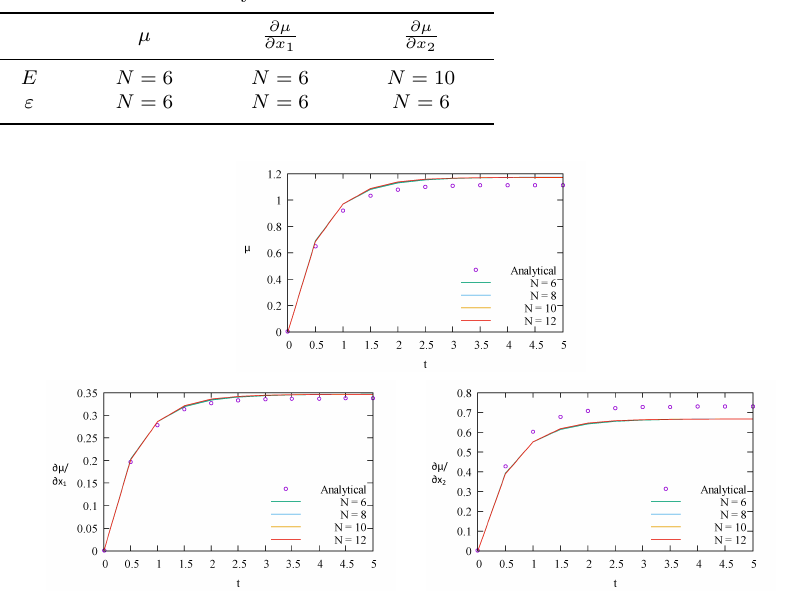
Figure 3. The solutions µ , ∂µ/∂x 1 and ∂µ/∂x 2 at ( x 1 ,x 2 ) = (0 . 5 , 0 . 5) for Case 1. For g ( x ) to satisfy (3.5), λ = 0. We choose